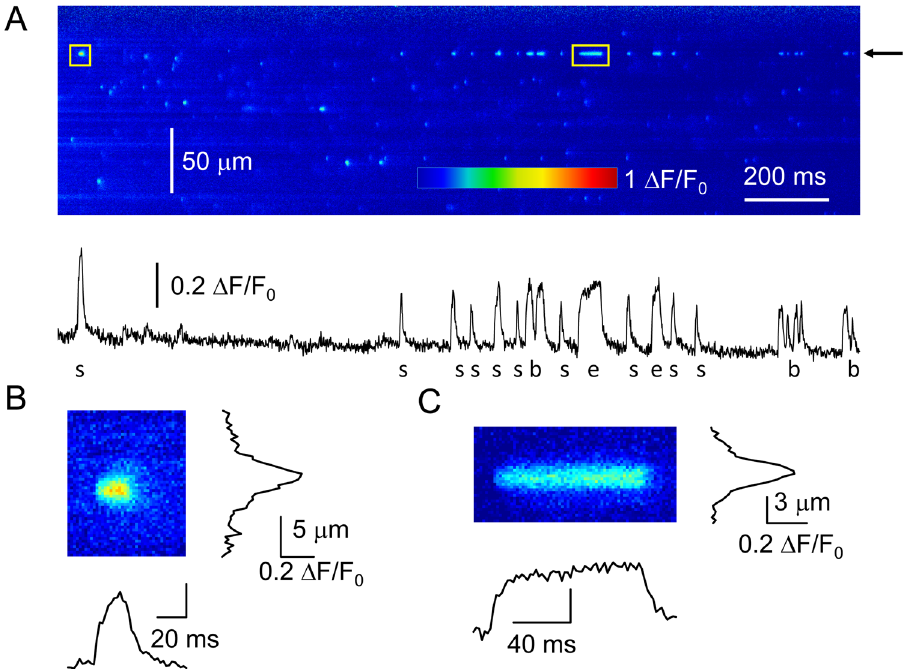
Figure 3. Sparks and embers on line-scan image. ( A ) Representative background corrected line-scan image measured with 2 ms/line scanning speed. The trace below the image was calculated by averaging 5 lines at the position marked by the arrow. Enlarged image of a spark ( B ) and an ember ( C ) with its spatial and time profile. The positions of the events are marked with yellow rectangular in panel A.